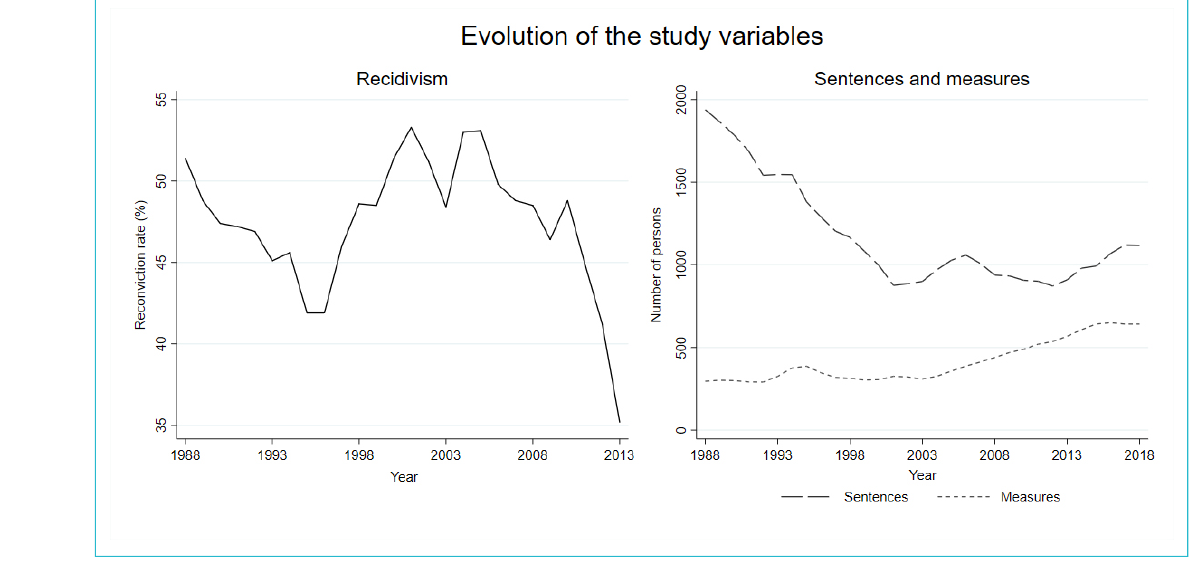
Figure 1: Change in recidivism rates, number of persons serving sentences and number of persons serving measures over time. Only Swiss nationals are